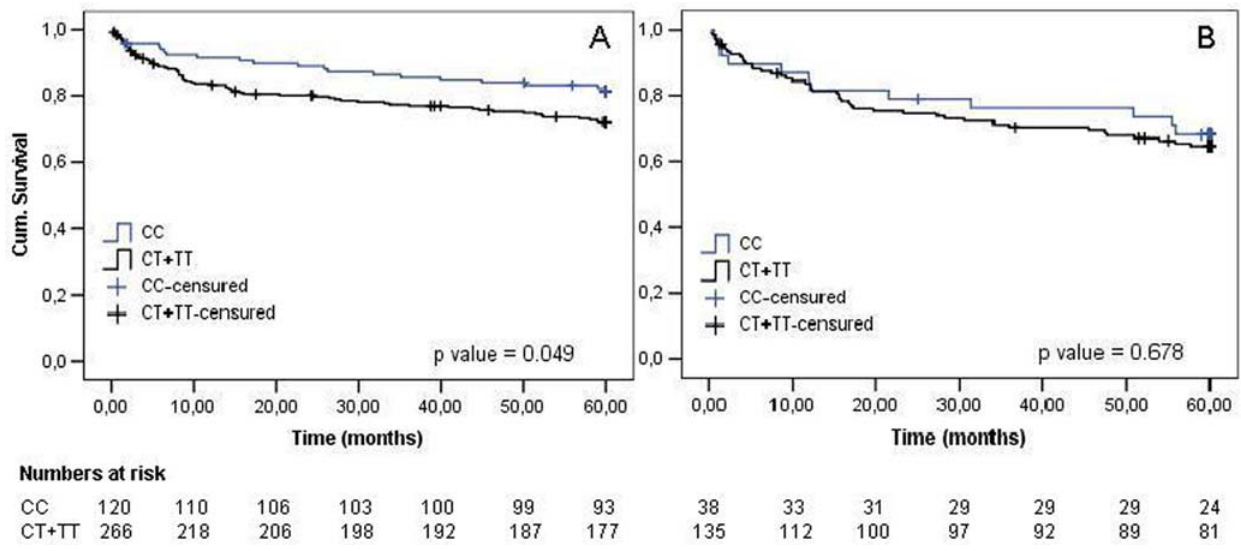
Figure 1. Kaplan-Meier Curve of TCF7L2 genotypes and composite cardiovascular end points in non-diabetic (A) and diabetic patients (B) after 5 years of follow-up. In non-diabetic patients, individuals CT and TT had a significant higher incidence of composite cardiovascular endopoints (death, non-fatal myocardial infarction, refractory angina requiring revascularization or new cardiac catheterization – PCI). Although diabetic individuals had a higher incidence of cardiovascular events than non-diabetics, a presence of T allele was not associated with cardiovascular endpoints.